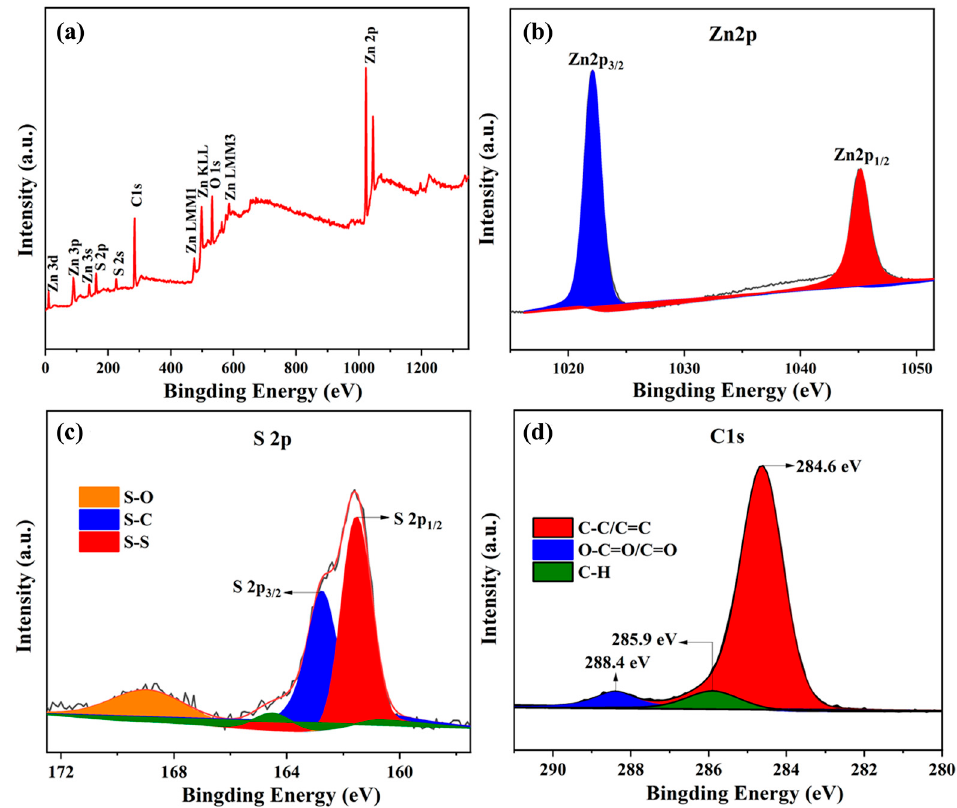
Figure 11. X-ray photoelectron spectra of the uncoated specimen after 200 vulcanizations: ( a ) survey spectrum, ( b ) Zn2p, ( c ) S2p, and ( d ) C1s.